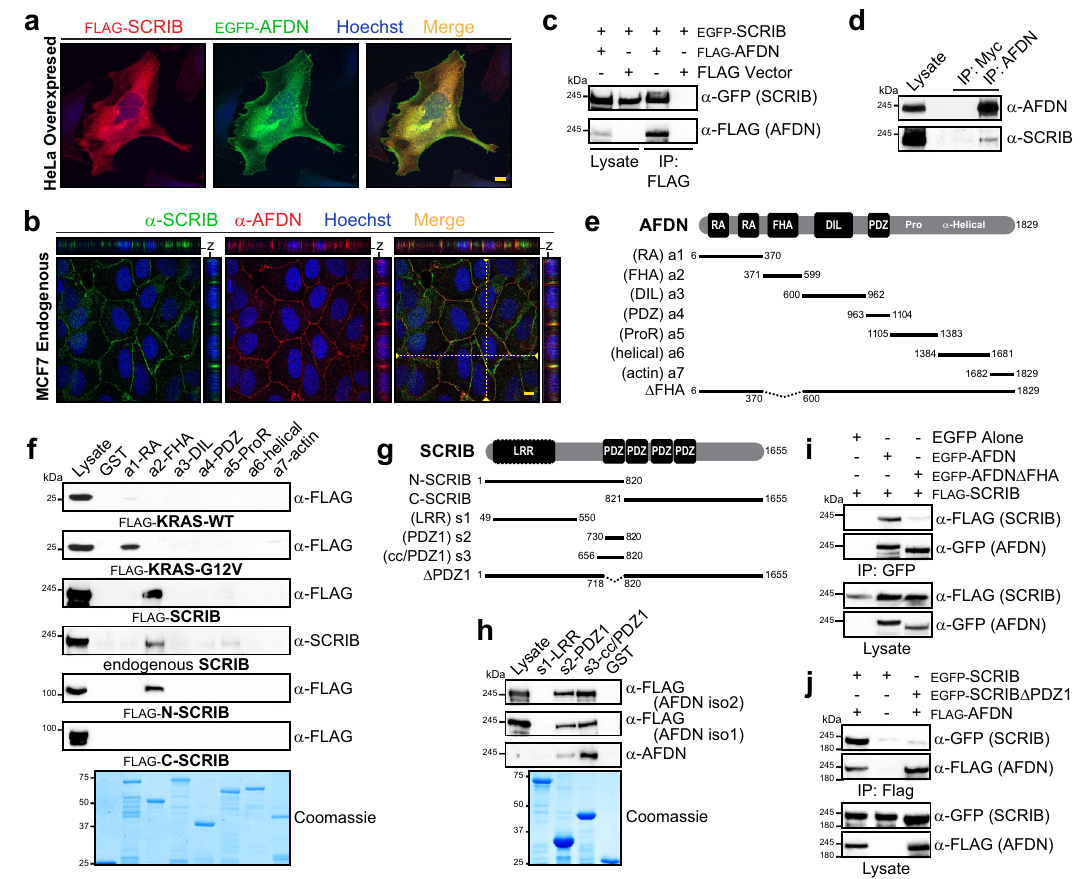
Fig.2|ASCRIB-AFDNcomplexismediatedbytheFHAdomainofAFDNandthe PDZ1 domain of SCRIB. a Localization of AFDN and SCRIB in HeLa cells. EGFP- AFDNandimmunostainedFLAG-SCRIBwereimagedbyconfocalmicroscopy.Scale barrepresents10 µ m. b EndogenousSCRIBandAFDNco-localizeatcellcontactsin MCF7 cells. Antibody speci fi city to endogenous AFDN/SCRIB is veri fi ed in Fig. 6a. Projections of z -stacks are at right and top of the merged images, with position shown by dashed yellow line. Scale bar represents 10 µ m. c Full-length AFDN and SCRIBco-immunoprecipitate(IP).EGFP-taggedSCRIBandFLAG-taggedAFDNwere co-expressedinHEK293Tcells.IPwithanti-FLAGfollowedbyWesternblottingwith anti-GFP revealed the complex. Vector alone was a control. d Endogenous AFDN andSCRIBco-precipitate fromMDCKIIcells.FollowingAFDNIP,ananti-SCRIBblot con fi rmed the complex. No AFDN or SCRIB were observed in an anti-Myc IP (con- trol). e SevenfragmentscomprisingthewholeofAFDNweregenerated tomapthe interaction, generally encompassing the AFDN modular domains. f SCRIB is